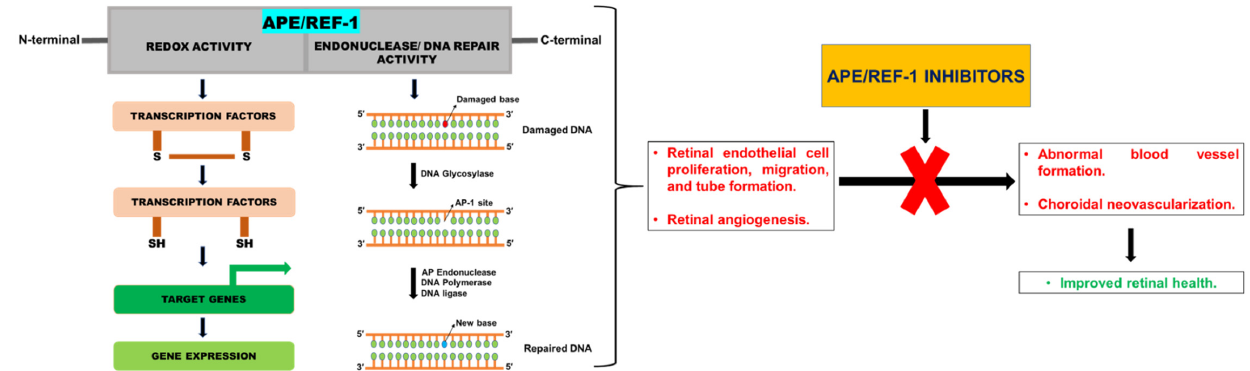
Figure 1 . APE/REF-1 inhibitors’ mechanism of action. APE/REF-1 possesses both redox activity and DNA repair activity via which it contributes to retinal angiogenesis, endothelial cell proliferation, migration, and tube formation. Addition of APE/REF-1 inhibitors blocks abnormal blood vessel formation and choroidal neovascularization, thereby improving retinal health.